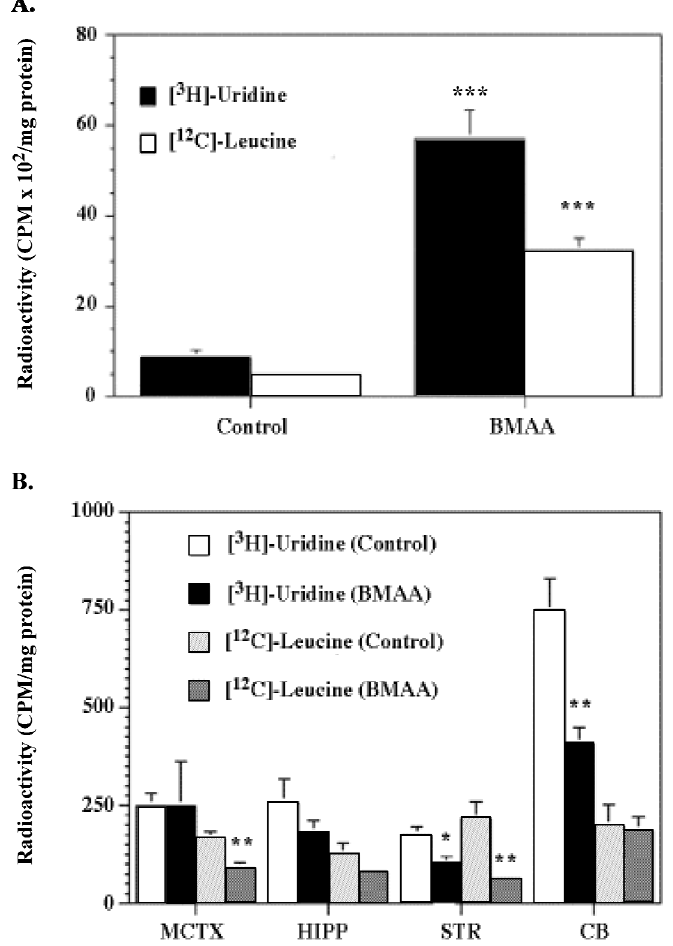
Figure 6. Effect of L-BMAA on rodent brain RNA and protein synthesis. ( A ) Effect of L-BMAA (24 h) on RNA and protein synthesis in mouse cortical explants 1 ; ( B ) Effect of L-BMAA on RNA and protein synthesis in various brain regions of adult rats 2 . Graphs derived from unpublished